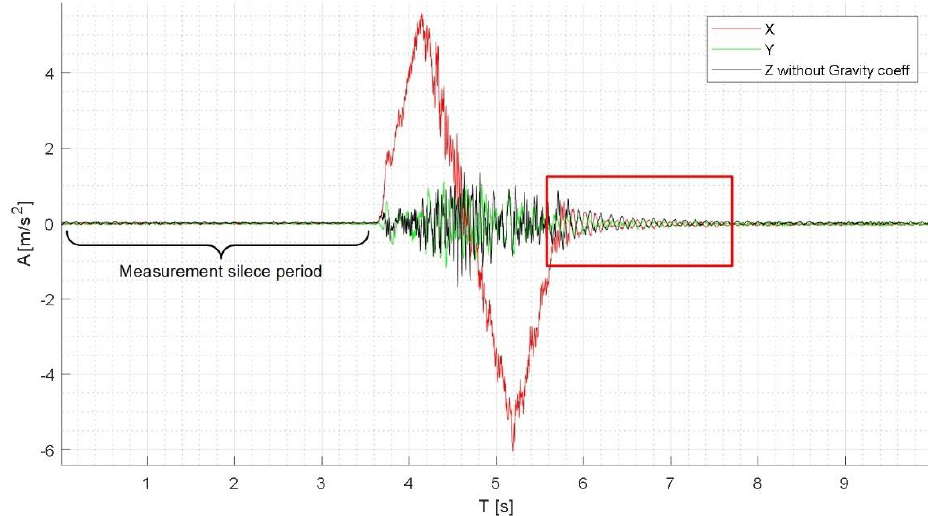
Figure 14. Graphs of accelerations acquired with MTi XSENS sensors mounted on the gripper for V4000, ACC100 parameters for the X, Y, and Z axes.